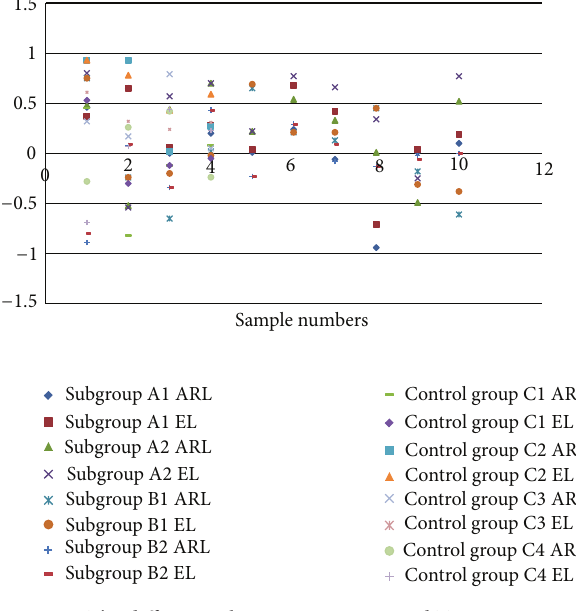
Figure 1: The differences between ARL, EL, and TL measurements of all samples